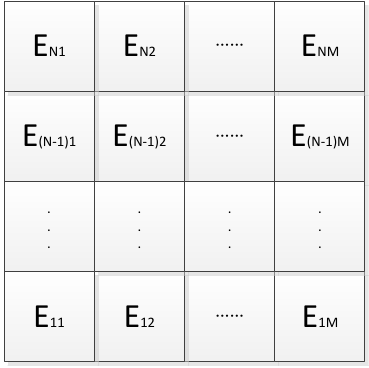
Figure 11. TDICCD photosensitive charge